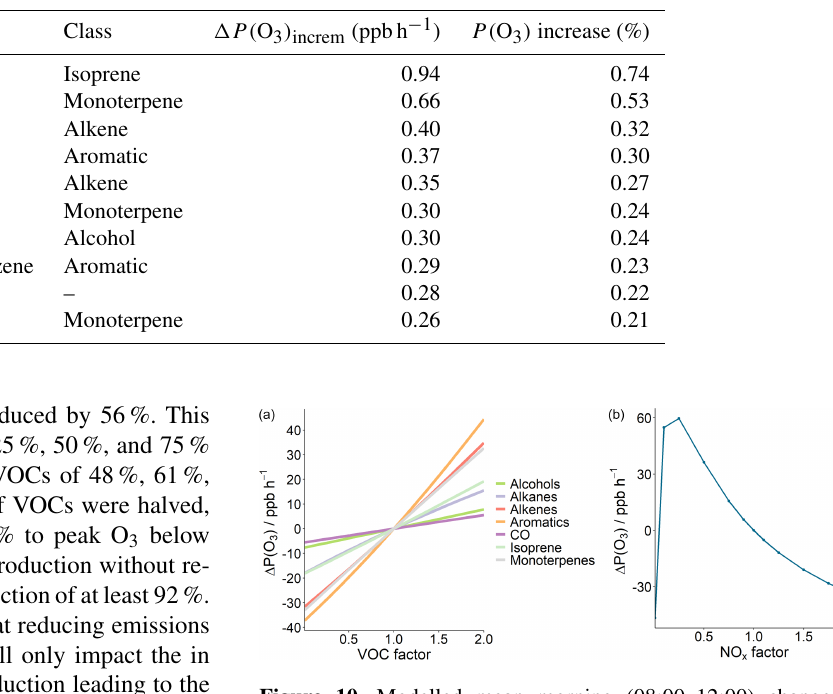
Figure 10. Modelled mean morning (08:00–12:00) change in P( O 3 ) rate for CO and six VOC classes upon varying their con- centrations by multiplying by the “VOC factor” (a) and by varying just NO x (b)